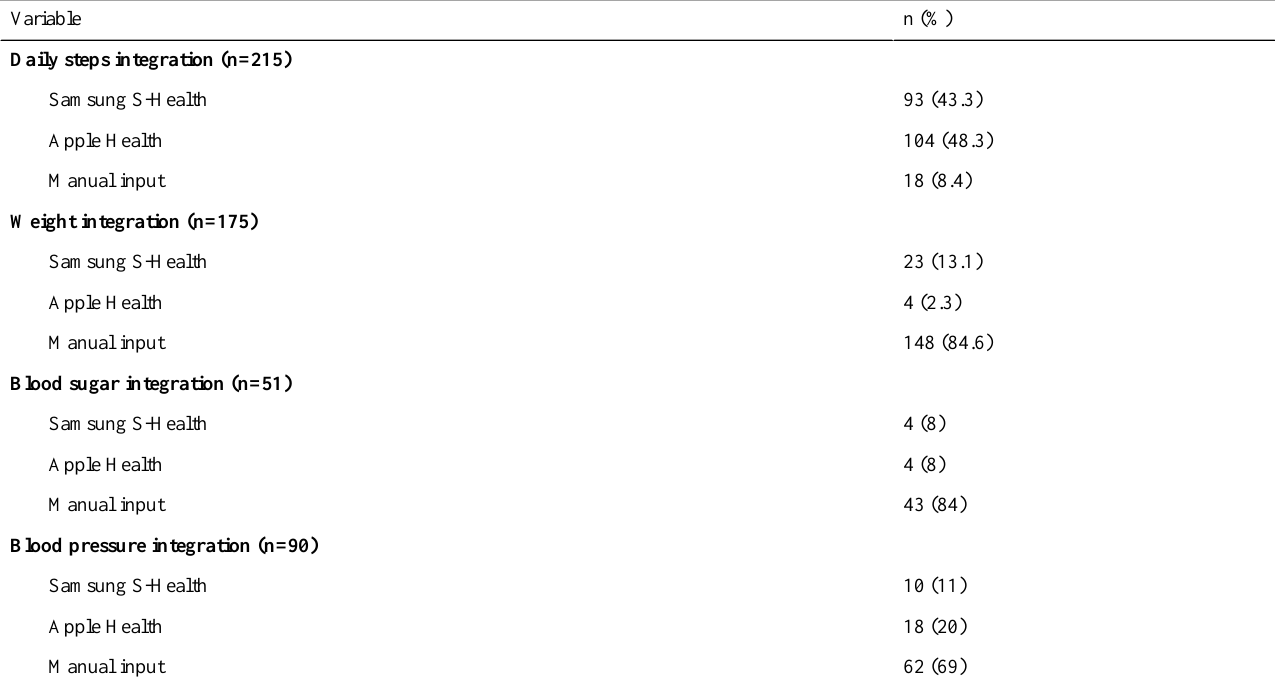
Table 3. Platforms for integrating daily steps, weight, blood sugar, and blood pressure data.